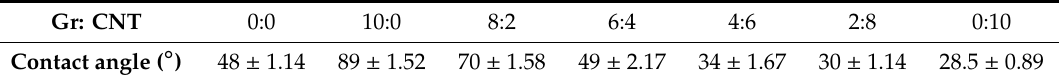
Figure 7. Water contact angle of PVA / SA / Gr / CNT nanofibrous membranes as related to Gr-CNT ratios. (Control: PVA / SA nanofibrous membranes). Table 2. Contact angle and standard deviation of nanofiber